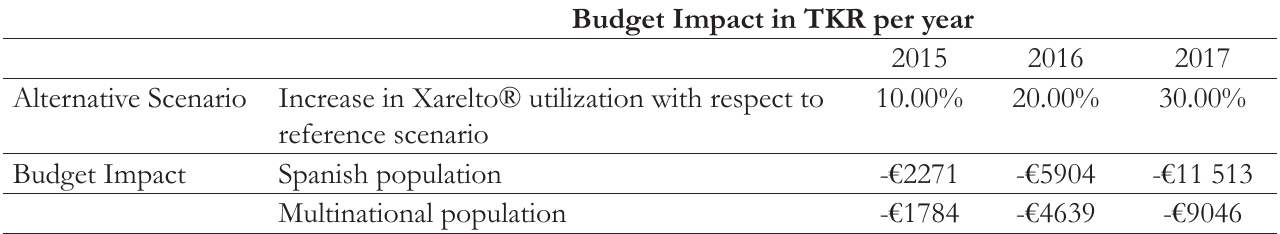
Table 6. Budget Impact when increasing Rivaroxaban Utilization by Year in TKR Patients in